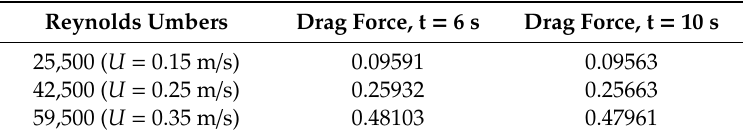
Table 5. Change in drag force with the Reynolds numbers for t = 6 s and t = 10 s.